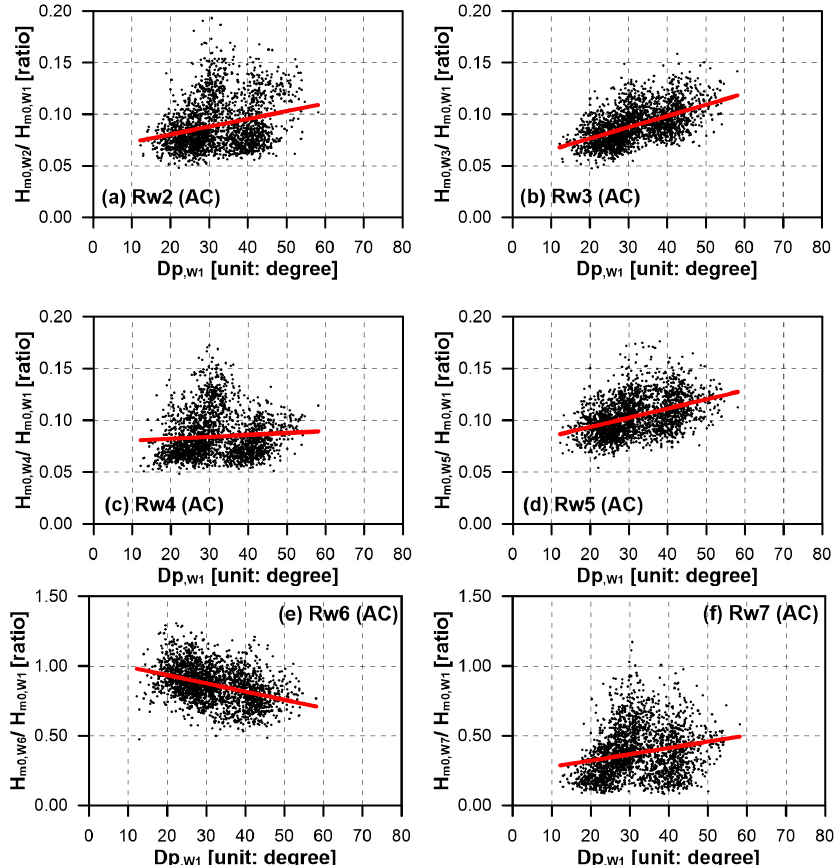
Figure 9. Same as Figure 8, but for the data measured during the 27 wave events in AC. Similar to the case of BC, it was found that R W # consistently tended to increase with increasing D p , W 1 in the wave stations inside the port (W2, W3, W4, and W5) and that located in the west corner of Yeongil Bay (W7), whereas R W # decreased with increasing D p , W 1 in the wave station located in the southeast corner of the bay. Table 3. List of coefficients of determination ( r 2 ) and linear regression coefficients (slope and intercept) for the scatter plots in Figures